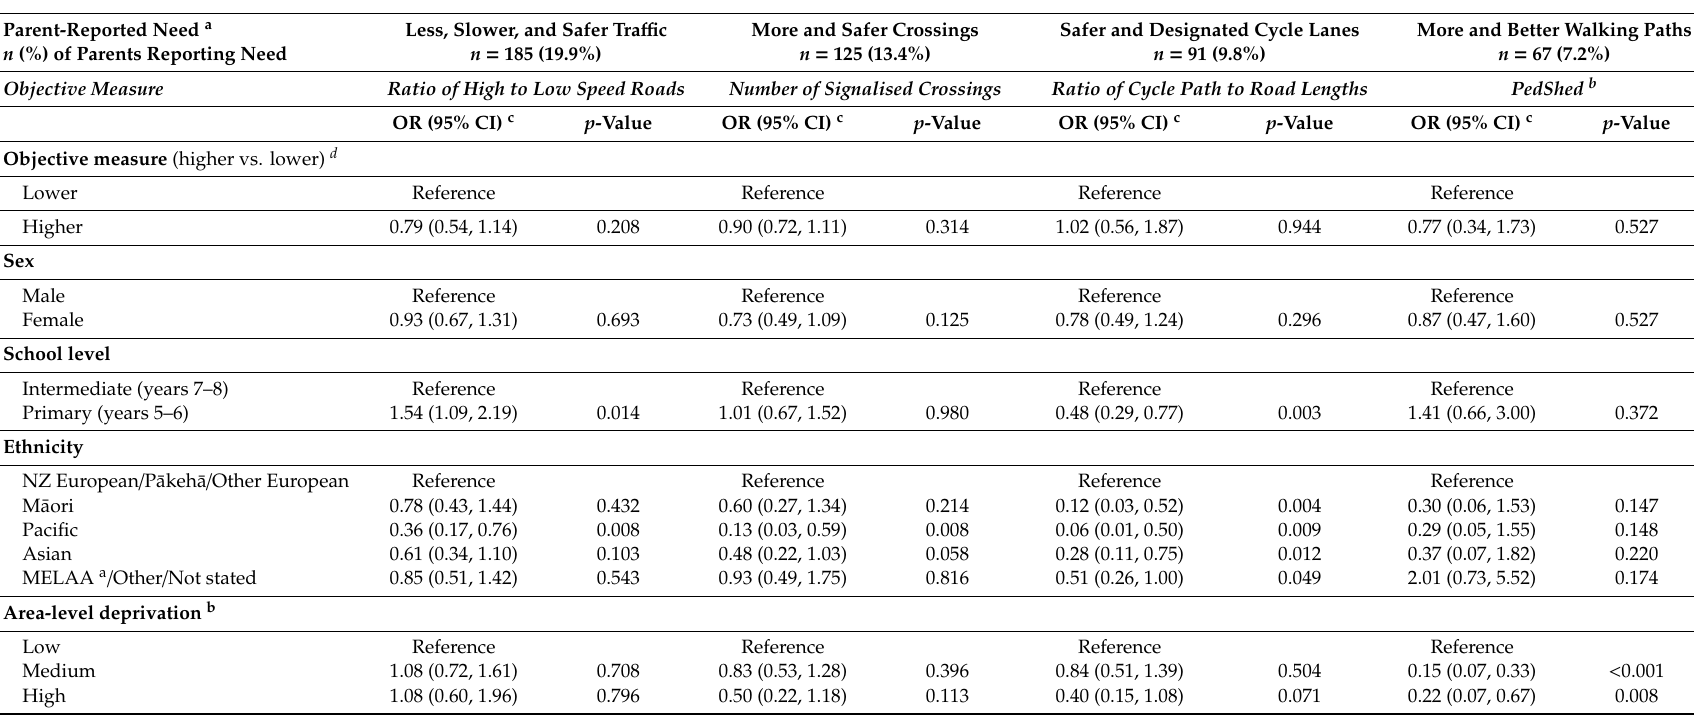
Table 5. Di ff erences in parent-reported needs by objectively-assessed neighbourhood built environment characteristics and socio-demographic factors ( n = 931). Parent-Reported Need a n (%) of Parents Reporting Need